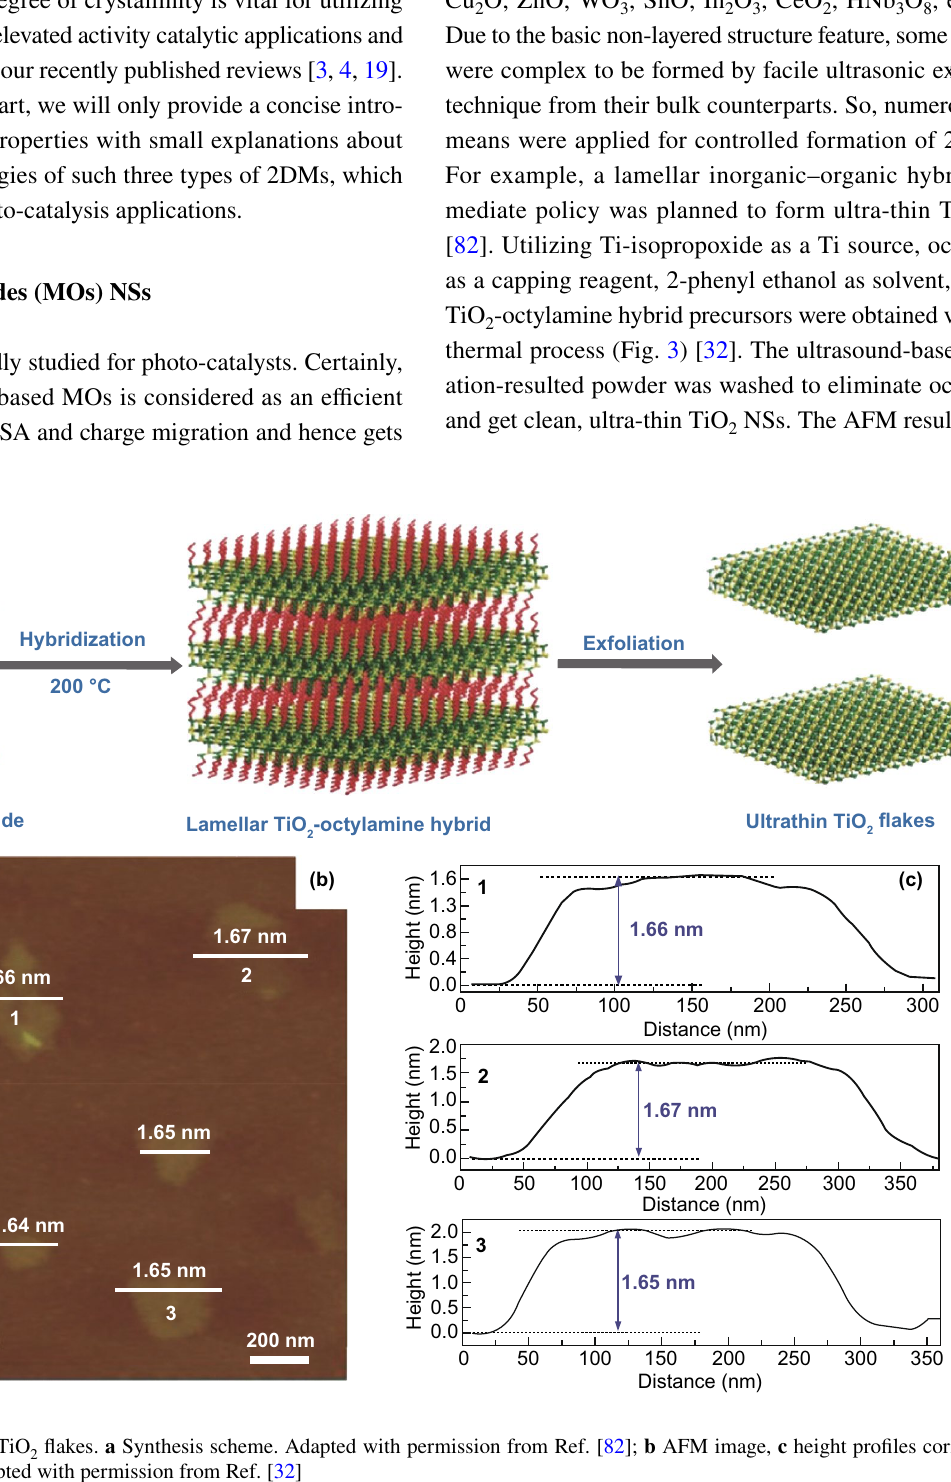
Fig. 3 The ultra‑thin TiO 2 flakes. a Synthesis scheme. Adapted with permission from Ref. [82]; b AFM image, c height profiles correspond to AFM image in b . Adapted with permission from Ref.